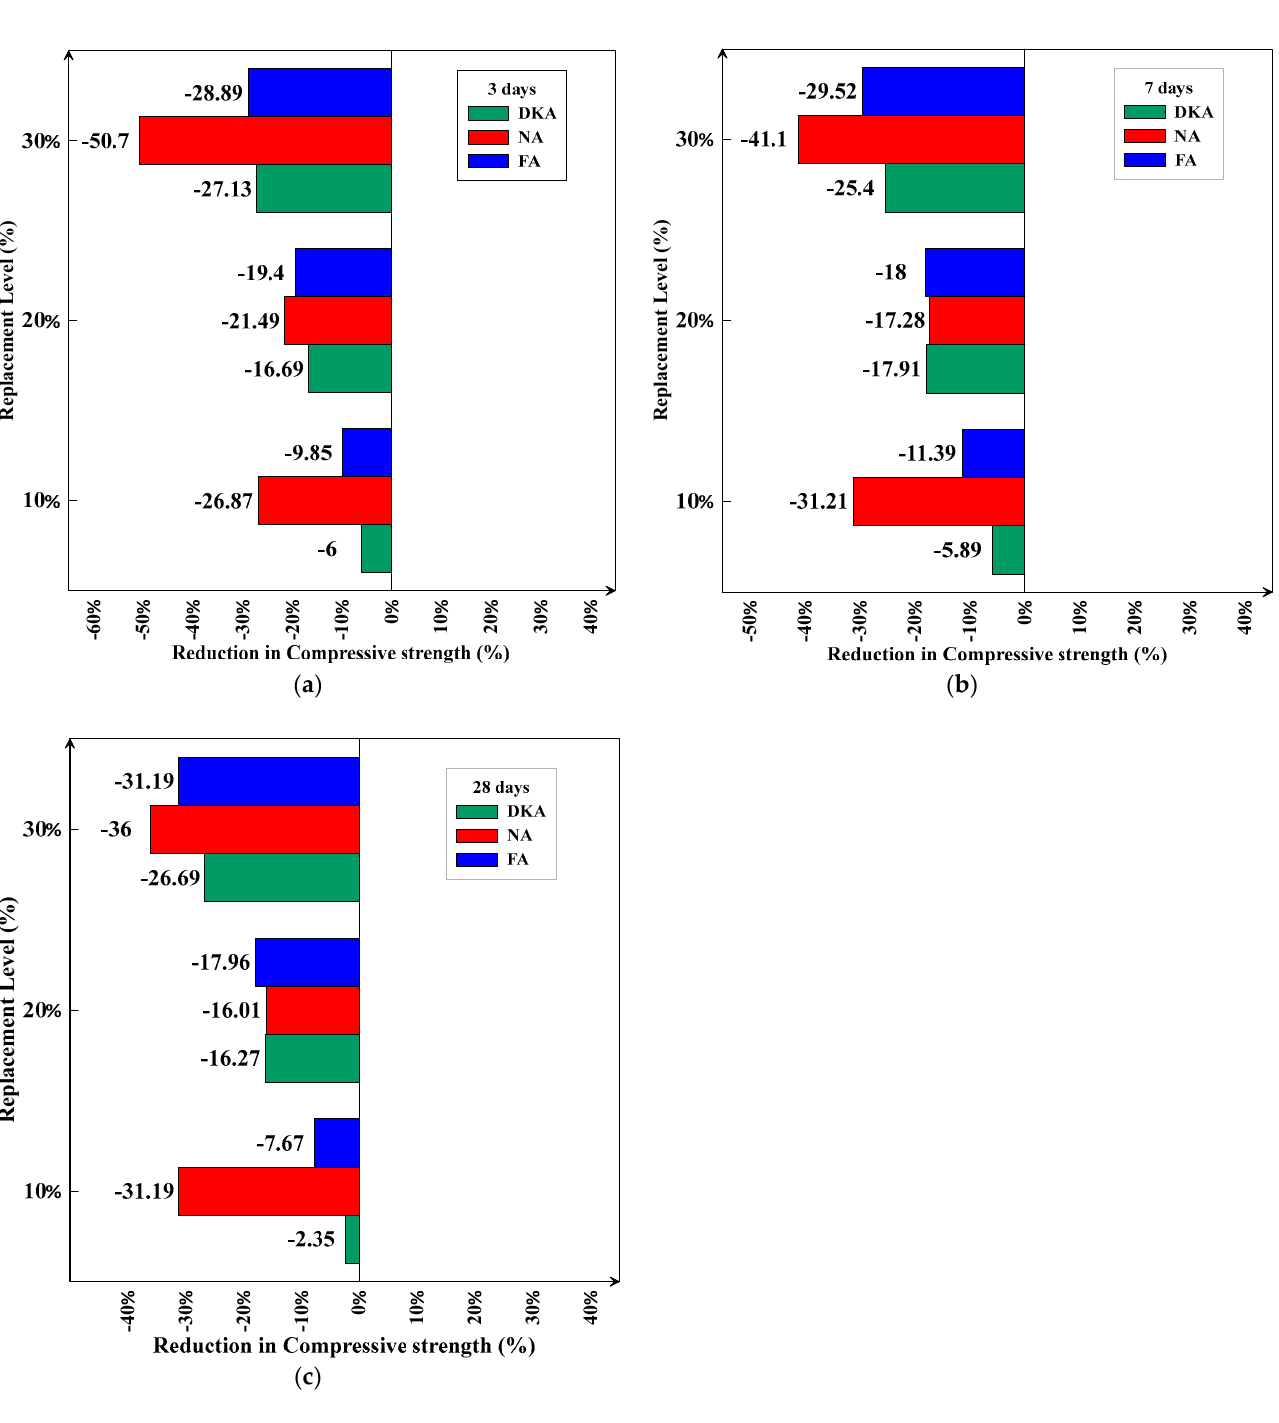
Figure 23. Reduction in compressive strength %. ( a ) DKA, ( b ) FA, and ( c ) NP. The tensile strength of concrete mixtures at 3, 7, and 28 days of age was measured and is shown in Figure 24a–c. It can be seen in Figure 21 that the effects of DKA, NP, and FA on the tensile strength of concrete are approximately the same as their effects on the compressive strength of concrete. The tensile strength of the mix containing 5% DKA is 6.89%, 9.35%, and 5.93% higher than the control mix at 3, 7, and 28 days of age, respectively. At replacement percentages of 10%, 20%, and 30%, DKA exhibits higher tensile strength than NP and FA, but it is lower than the control OPC mix (see Figure 24b). As the replacement level of DKA, FA, and NP increases, the tensile strength decreases, as shown in Figure